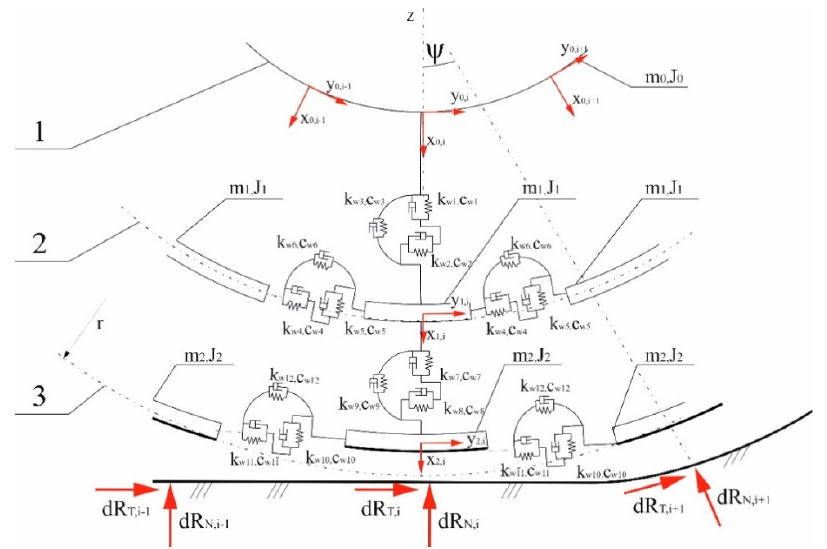
Figure 5. Wheel model structure: 1—wheel rim; 2—carcass; 3—thread; dR N,i —elementary normal reaction of the substrate; dR T,i —elementary tangential reaction of the substrate; ψ i —angle of operation of an elementary normal force measured from a vertical line Z.